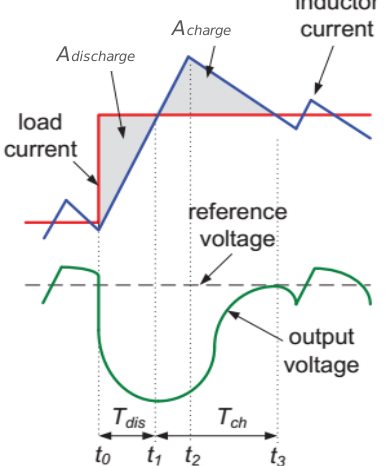
Figure 11. Optimal inductor current path for load current change (top: inductor current, bottom: capacitor voltage).